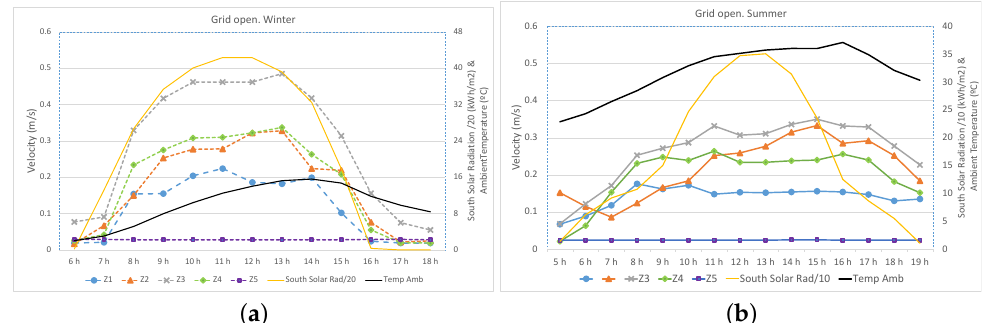
Figure 10. Open ventilation grills. Trend of the measured air cavity velocity: ( a ) for a winter day (14 January 2021); ( b ) for a summer day (5 July 2021). South solar radiation and ambient temperatures are